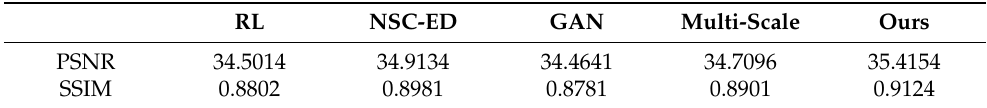
Table 3. Quantitative results of different